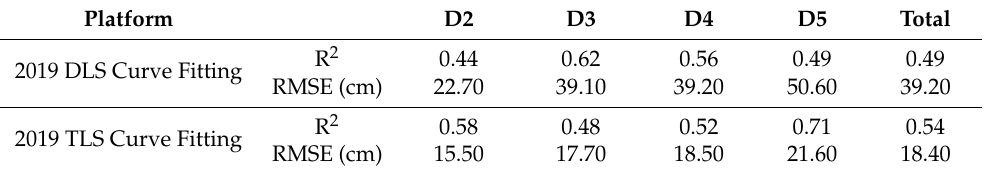
Table 10. R 2 and RMSE after curve fitting of data on different platforms in 2019.